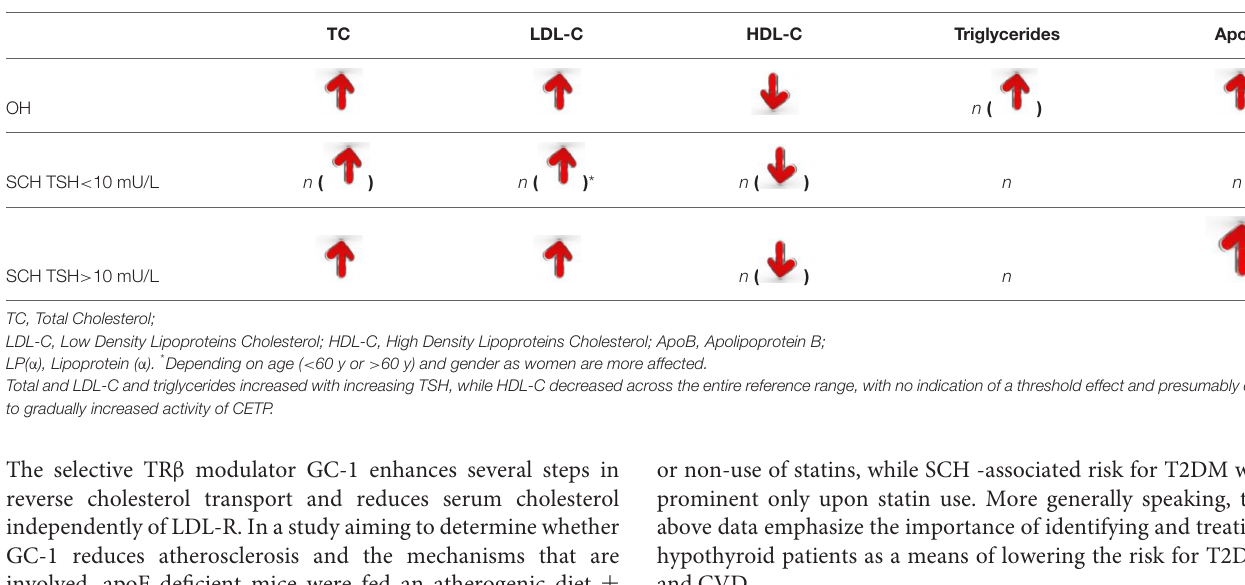
TABLE 2 | The impact of overt (OH) and subclinical hypothyroidism (SCH) on serum lipids